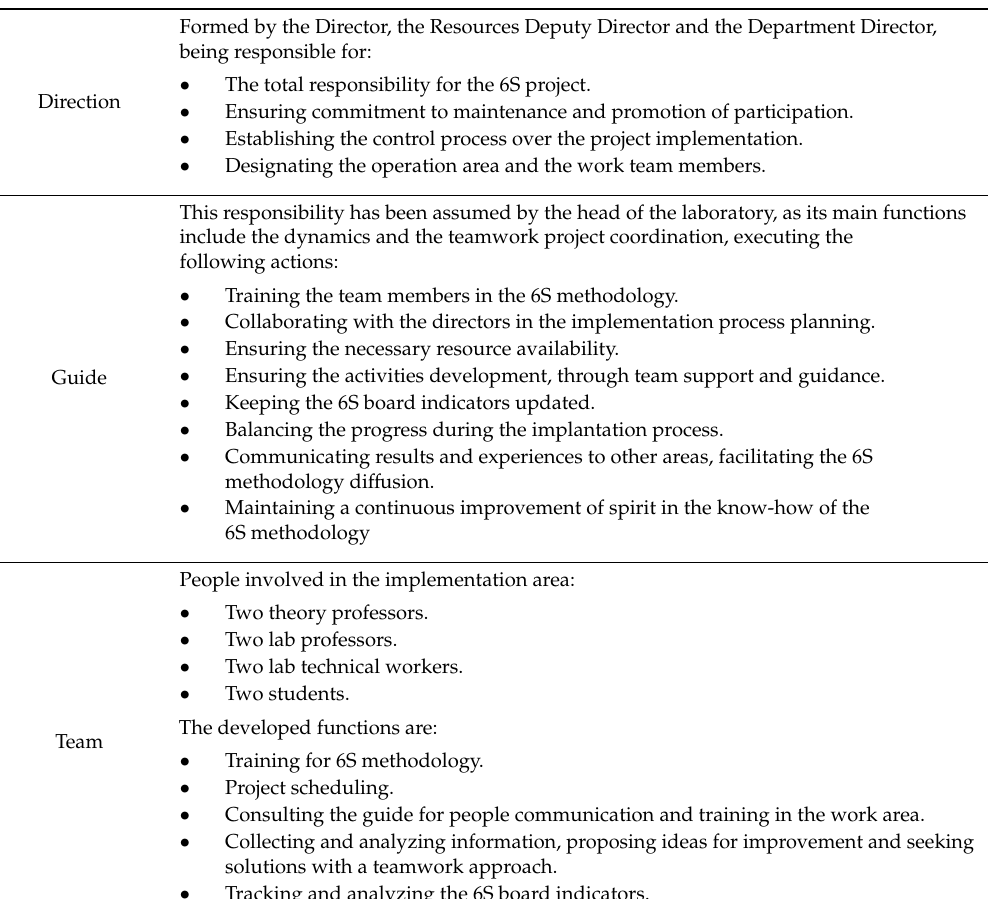
Table 3. Participants involved in the process